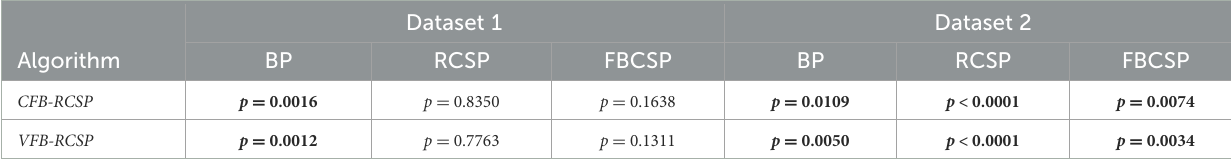
TABLE 3 One-way repeated measures ANOVA statistical test results, p < 0.05 means that the results are significant.